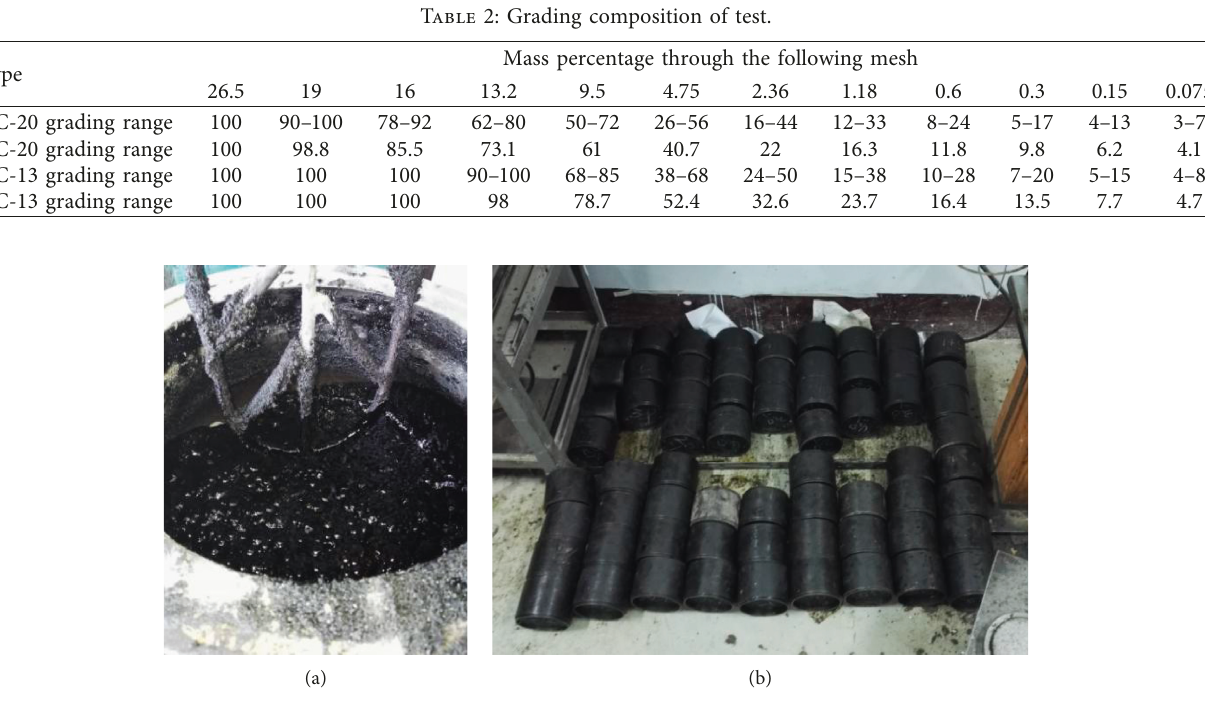
Figure 2: Specimens for mixing and preparation of foam asphalt mixture. Table 3: List of the best oil-stone ratio of warm mix foamed asphalt